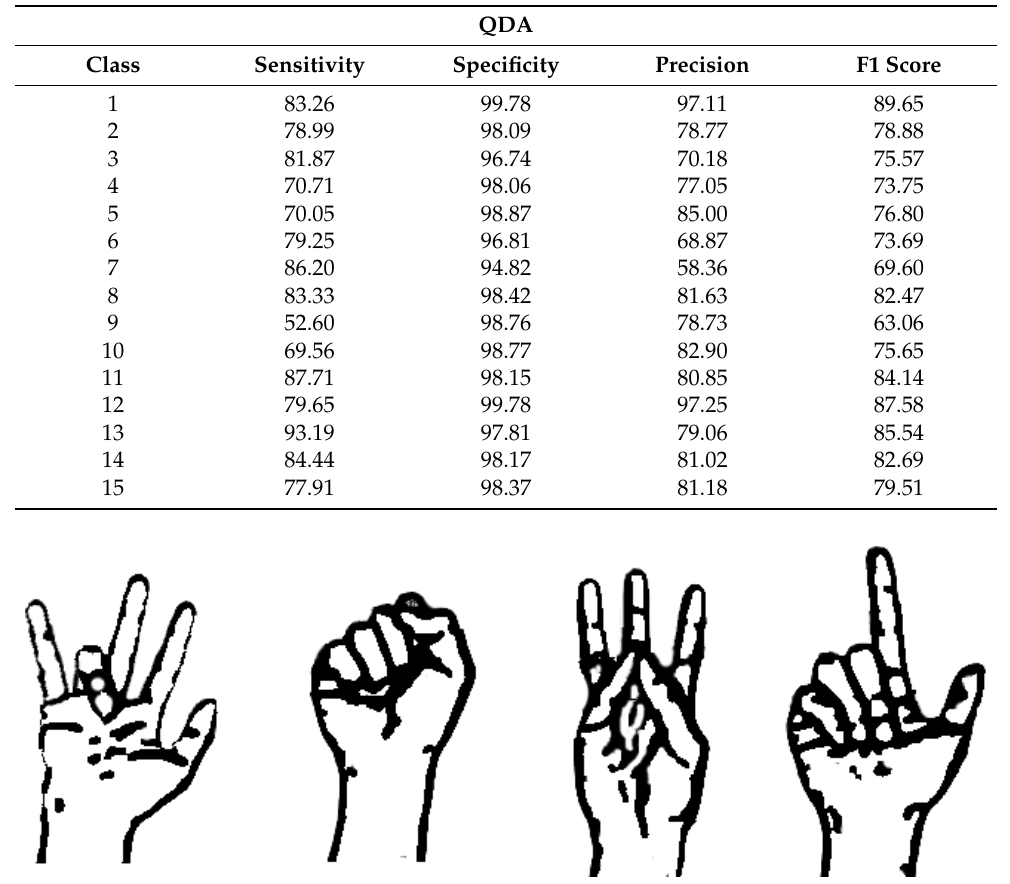
Figure 10. Hand gestures with perfect recognition. From left to right, the classes 10 (R_R), 1 (HC), 12 (T_L) and 8 (MRL).